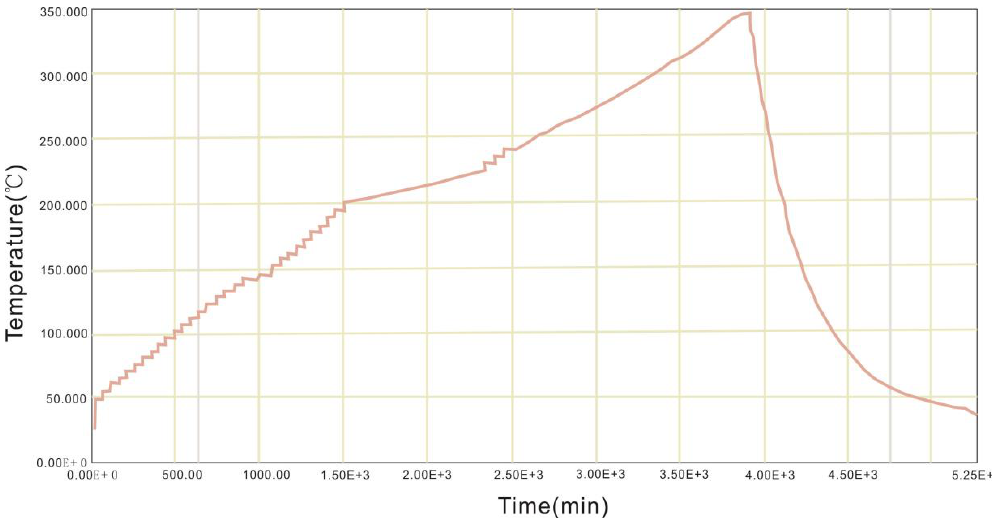
Figure 3. Adiabatic oxidation process temperature-time curve.